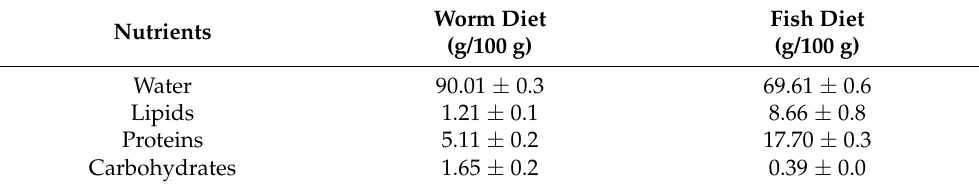
Table 1. Nutrient compositions of worm and fish diet. Values are presented as mean ± SE.